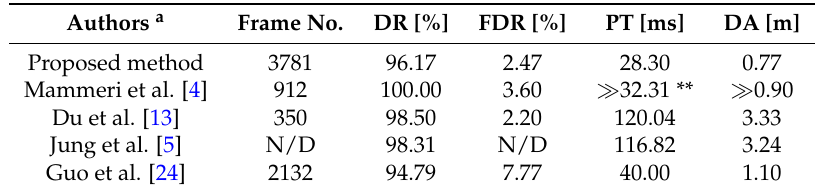
Table 4. Comparison of different techniques in drivable region